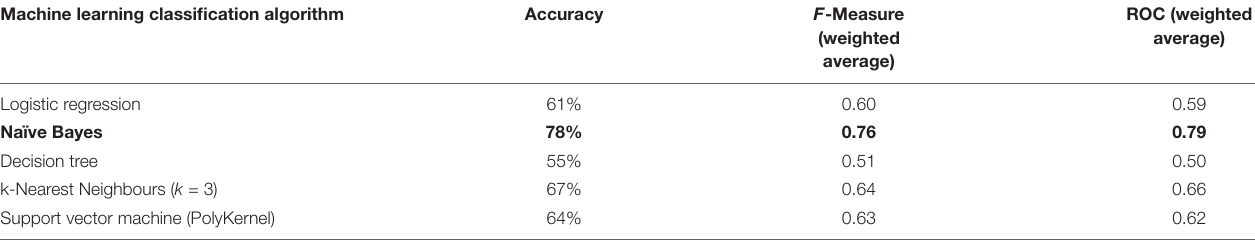
TABLE 4 | Machine learning classification results.